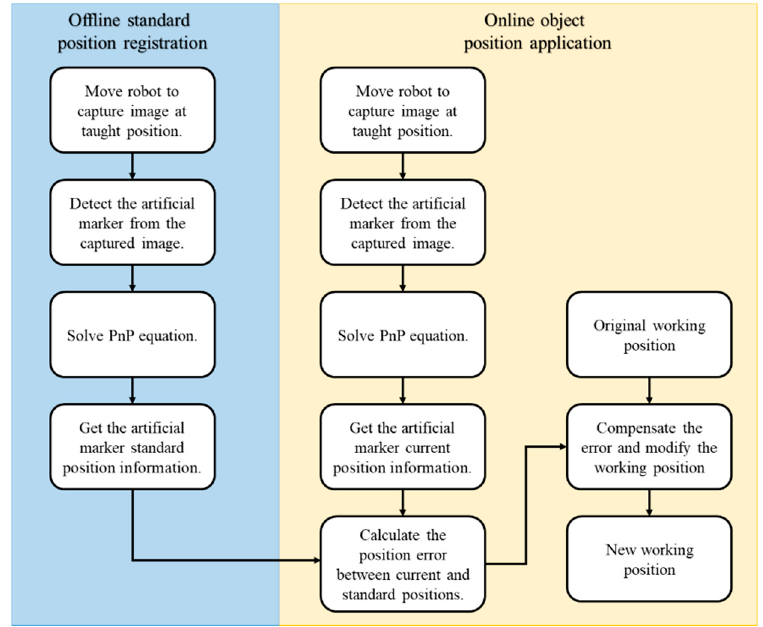
Figure 3. Flowchart of the object position correction